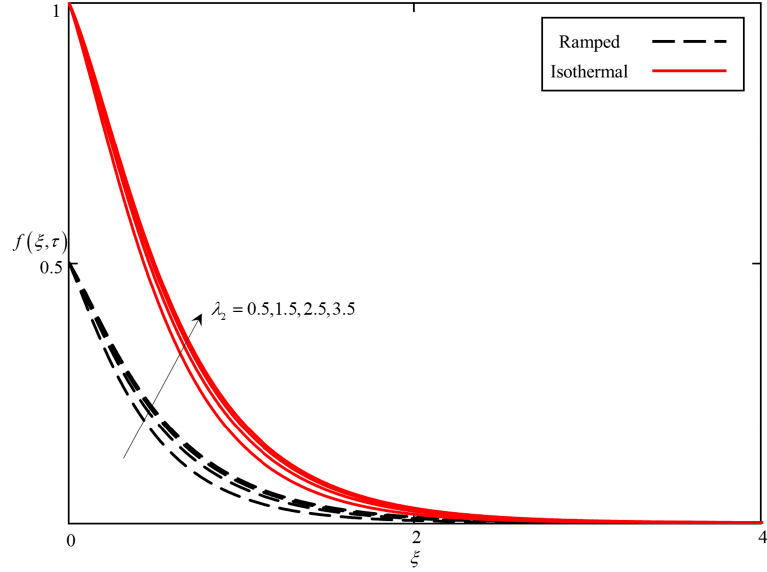
Figure 11. Consequence of λ 2 on the velocity field, when α = 0.5, β = 0.5, φ = 0.04, λ = 0.5, M = 0.5, K = 0.5, Pr = 21, and Gr =